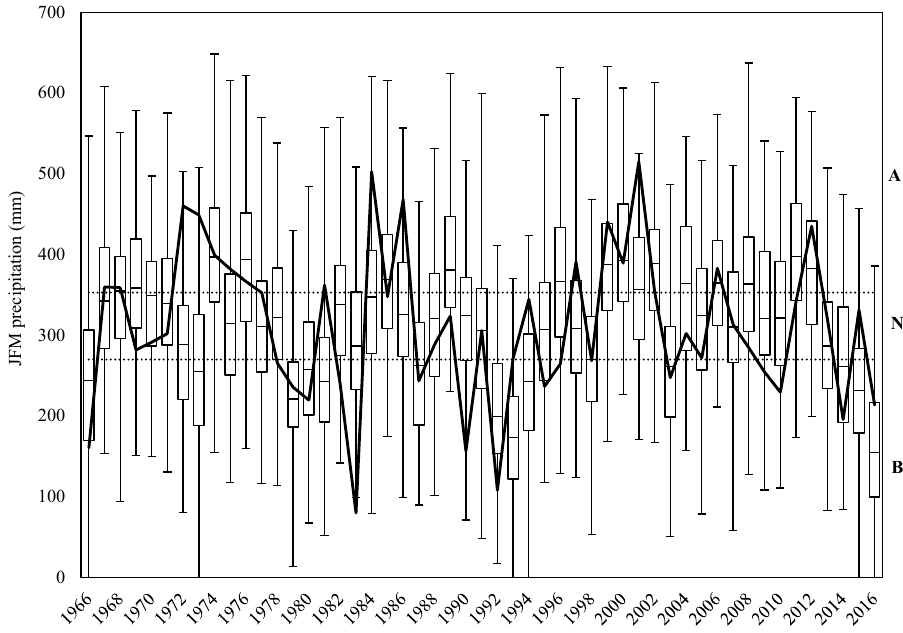
Figure 11. Box plots of cross-validated, ensemble forecasts of JFM precipitation with observed conditions (solid black line) and categorical thresholds (dotted lines, with delineated categories labeled A, N, and B) included.